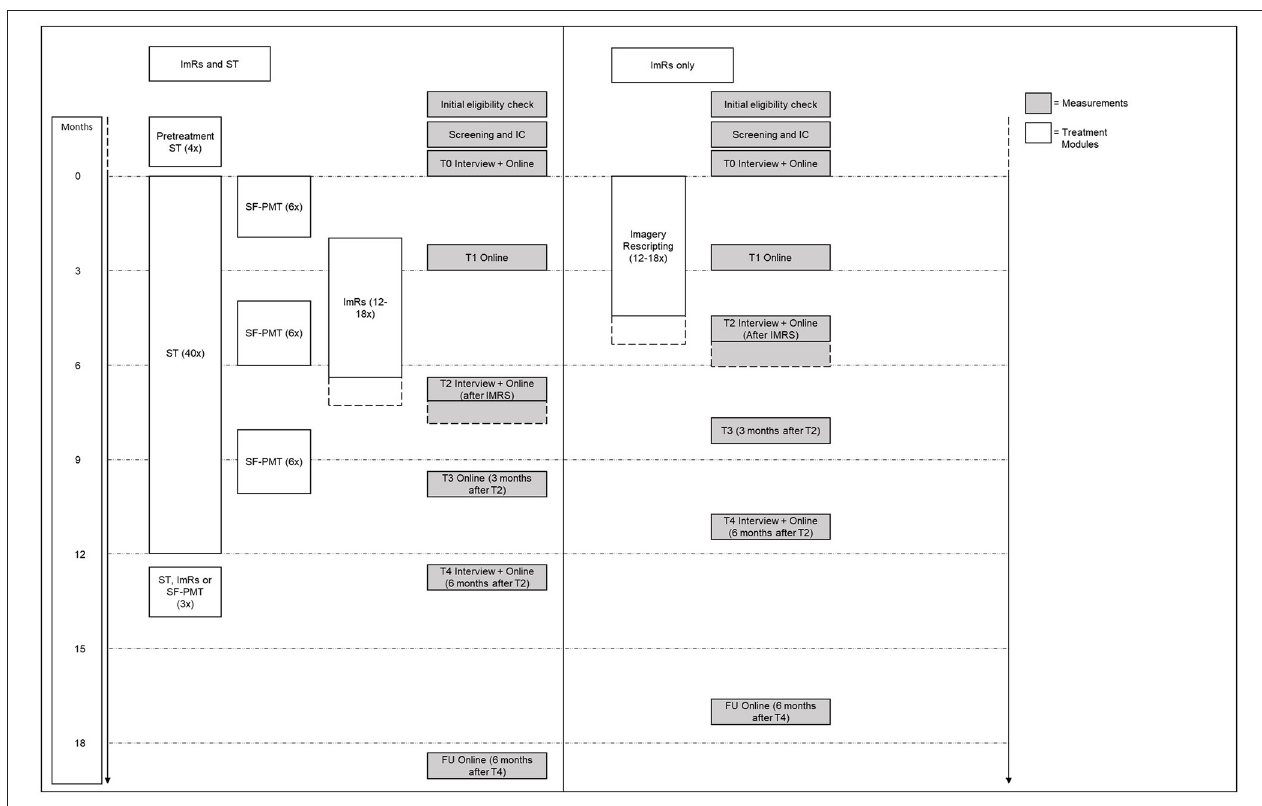
FIGURE 2 | Overview of the trial procedure for ImRs only and integrated ImRs and ST including treatment and measurement timing. ImRs, imagery rescripting; ST, Schema therapy; SF-PMT, Schema focused psychomotor therapy; IC, Informed consent; FU,